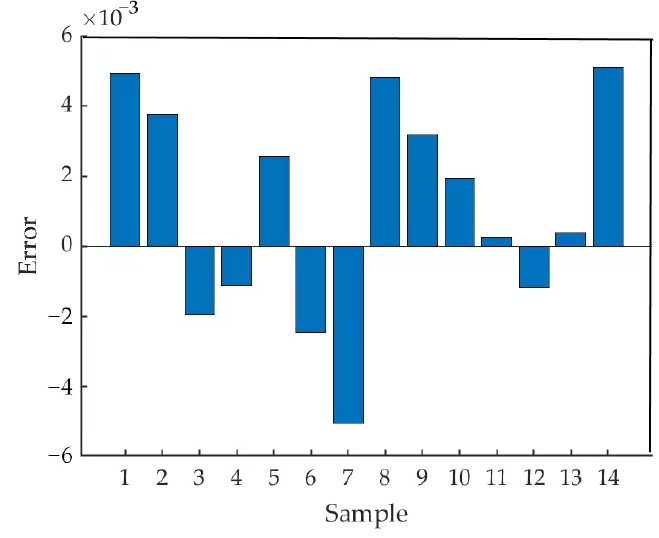
Figure 9. Prediction error of the moisture content of the PCA-SVR model.